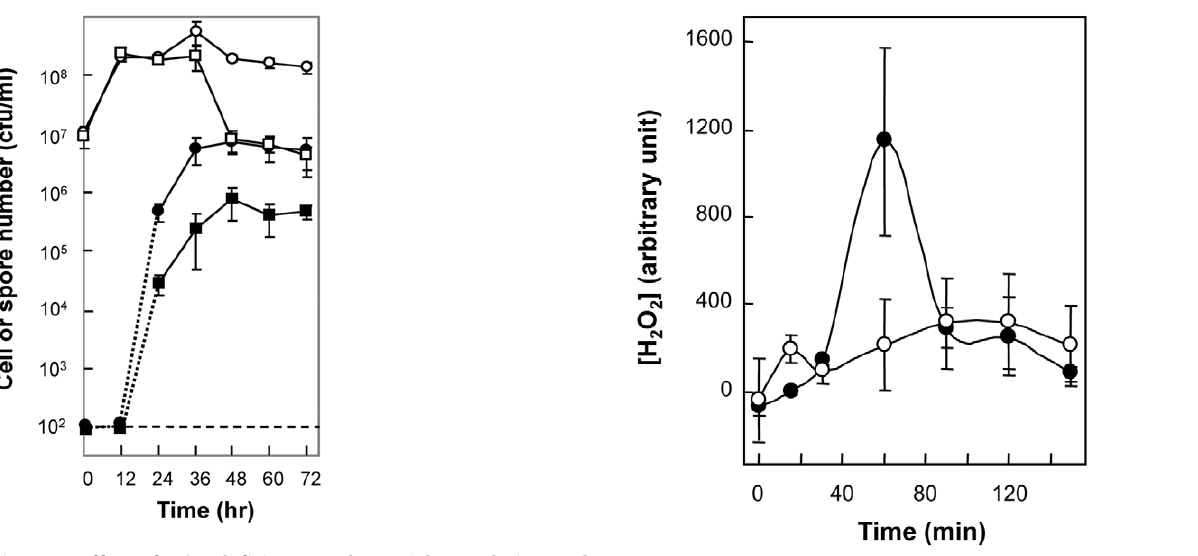
Figure 6. Effect of ndoA deficiency on peroxide accumulation following kanamycin treatment. Wild-type B. subtilis strain BD630 (filled circles) and its D ndoA mutant 3169 (open circles) were grown overnight, diluted 50-fold in LB medium, and treated with kanamycin (4 m g/ml). At the indicated times aliquots were removed for determi- nation of hydrogen peroxide as in Methods. Error bars indicate standard deviation; Similar results were obtained in replicate experiments.